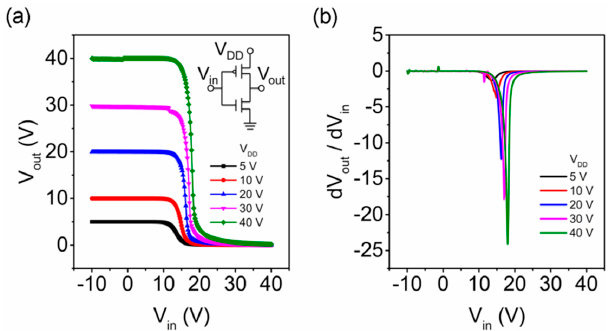
Figure 3. ( a ) Output voltage and ( b ) gain of the complementary inverter as a function of input voltage at different V DD .